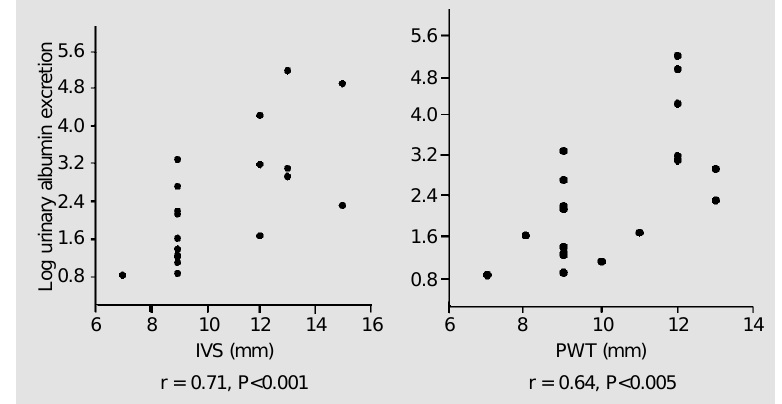
Figure 1. Correlations of microalbuminuria with interventricular septum thickness (IVS) and with left ventricular posterior wall thickness (PWT) for 20 patients.